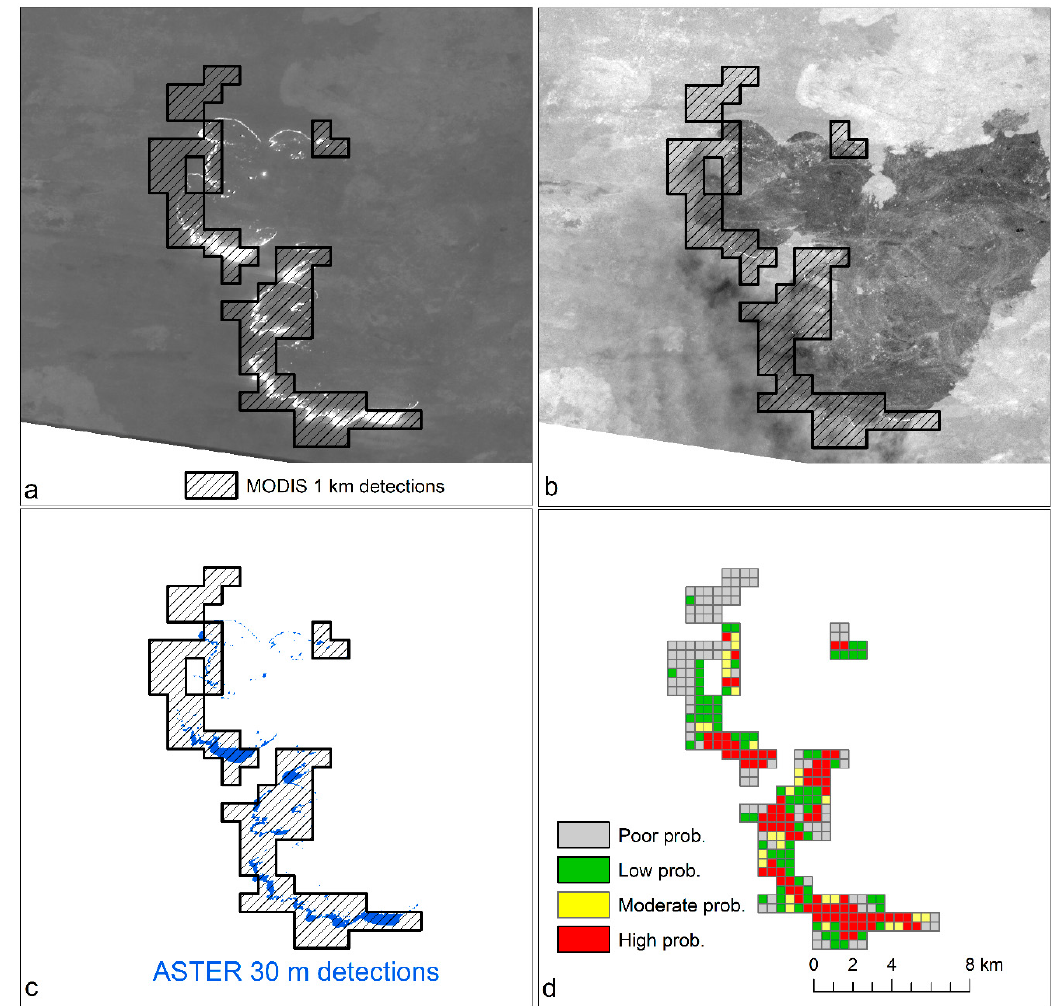
Figure 3. Proof of concept results over a savanna fire in Africa on 17 August 2001, DOY 229. Illustrated ( a ) 30 m ASTER Channel 9 (2.3 μ m) SWIR radiance with MODIS 1 km (crosshatched) detections. ( b ) 15 m ASTER Channel 3N (0.8 μ m) NIR reflectance. ( c ) ASTER fire detections (blue) superimposed with MODIS 1 km detections. ( d ) Results of this work, pixels colored by their probability classes (high (red), moderate (yellow) and low (green) and poor (gray)). Flaming fronts are visible within the MODIS 500 m pixels shaded red and yellow. No flaming fronts/ASTER fire detections are evident in the MODIS poor (green) and low (gray) probability pixels.